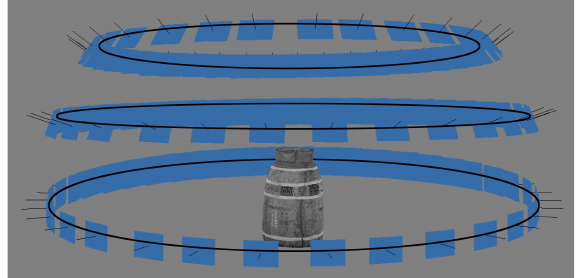
Figure 6. Camera positions for the 3D reconstruction image sets. The same camera positions were acquired for the three image sets from three camera angles and images every 10 ° .